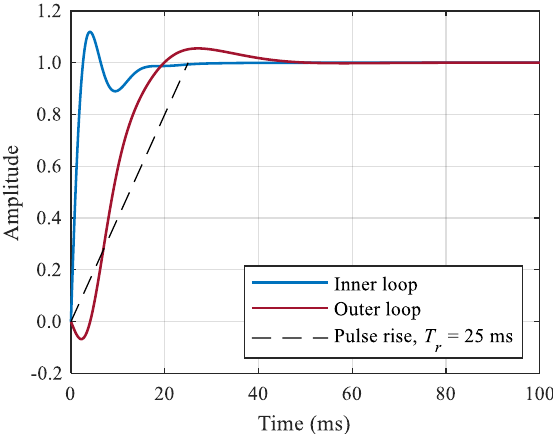
Figure 5. Unit step response of the inner and outer closed loop transfer functions of the DC/DC boost converter control system. Table 4. DC/DC converter parameters.